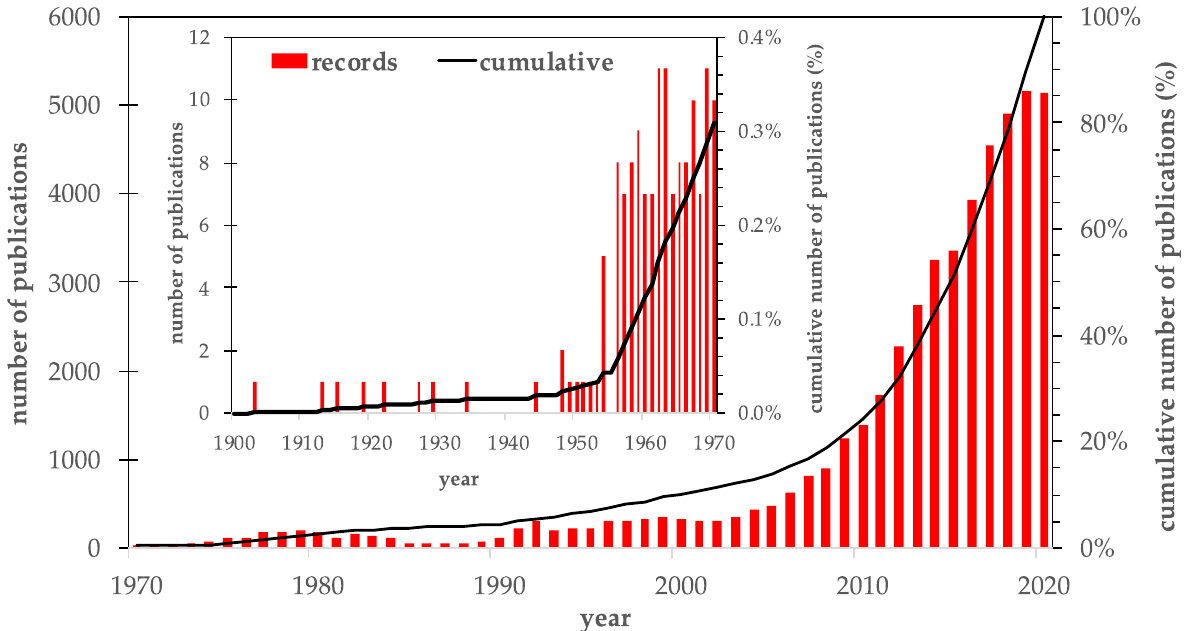
Figure 2. Number of publications evolution on Solar Energy research (between 1900 and 2020).